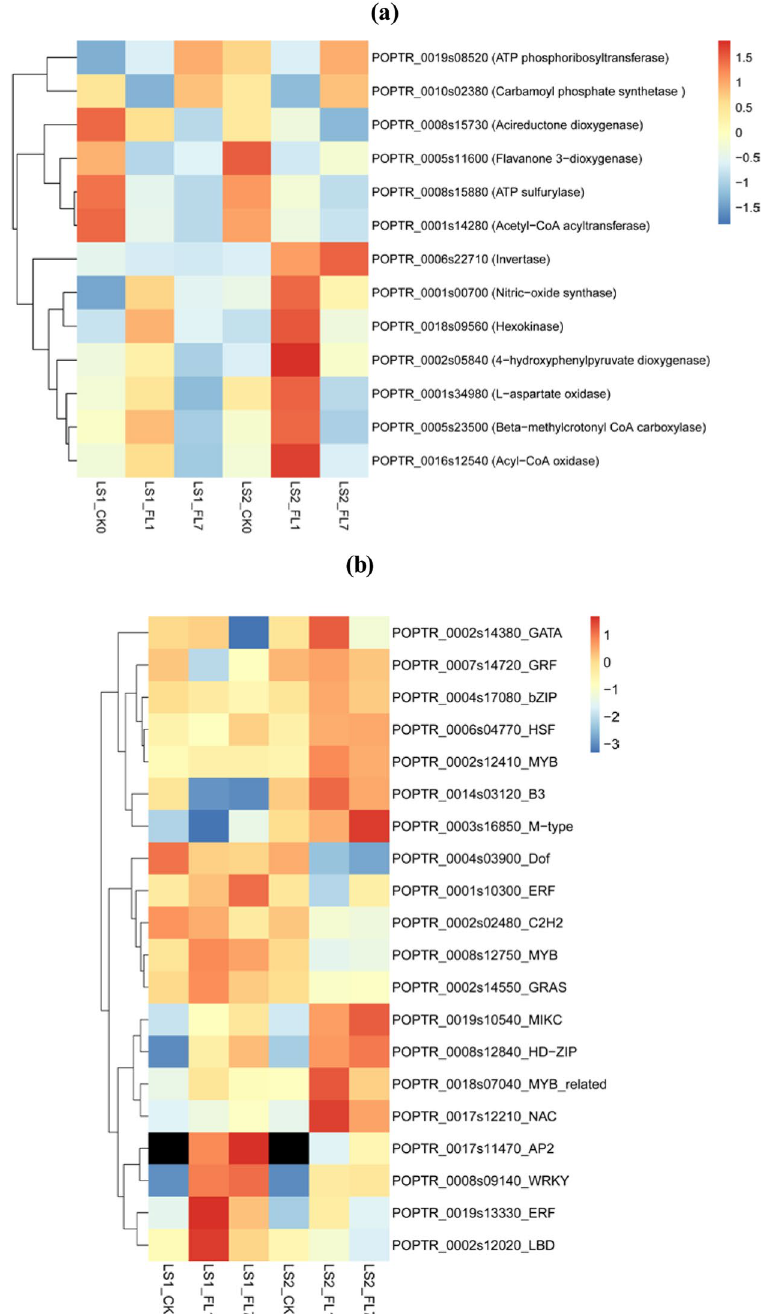
Figure 6. Heatmap of genes involved in ATP or O 2 consumption (a) and transcription factors ( b ) differently expressed between LS1 and LS2 under flooding stress. Log2-fold change values of gene RPKM values were normalized to means before heatmap